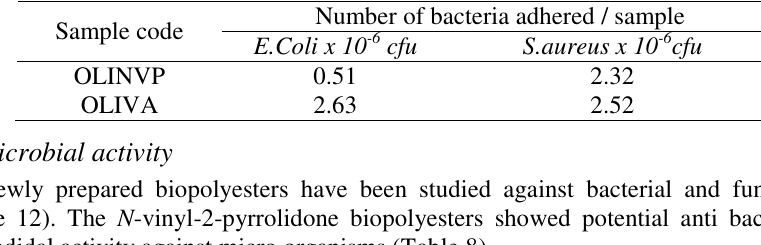
Table 7. Viable count / sample for biopolyester